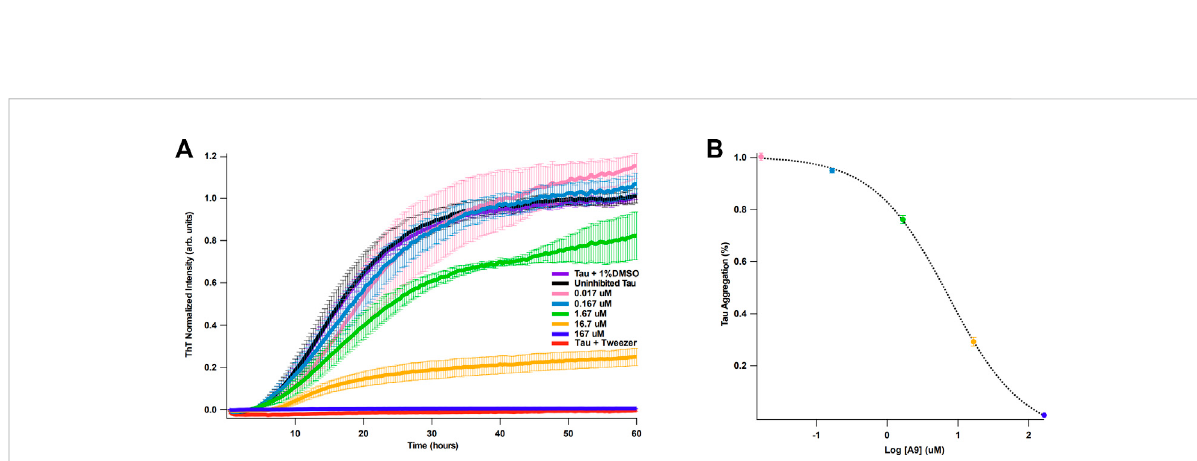
FIGURE 4 A9 inhibits heparin-induced tau aggregation with μ M af fi nity. (A) Tau aggregation monitored by ThT fl uorescence assay in the presence and absenceofA9.Theuninhibitedtauaggregationcontrolisshowninblack,theinhibitedtauaggregationcontrolisshowninred,andtheadditionof1% DMSO control is shown in purple. Inhibition of tau aggregation by varying concentrations of A9 are shown in pink, blue, green, orange, and navy (0.017, 0.167, 1.67, 16.7, and 167 μ M, respectively). Tweezer was used a positive control for aggregation inhibition. Heparin at 10 μ M was used across all samples to induce tau aggregation. (B) Plot of percentage tau aggregation inhibition as a function of A9 concentration ( μ M) in semi-log scale fi tted to a sigmoidal model. The fi tting was used to calculate the IC 50 value of A9. Data is represented as mean ± standard deviation generated from three repeat measurements. The tau aggregation (%) data was normalized to the lowest concentration of A9 (0.017 μ M).